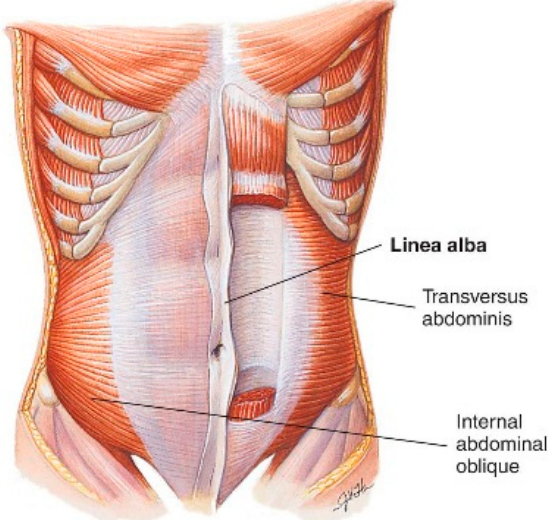
Figure 4. The linea alba runs the length of the abdominal midline from the xiphoid process to the pubic symphysis [10] (This article was published in Anatomy & Physiology, Thibodeau GA & Patton KT, p. 325, Copyright Elsevier